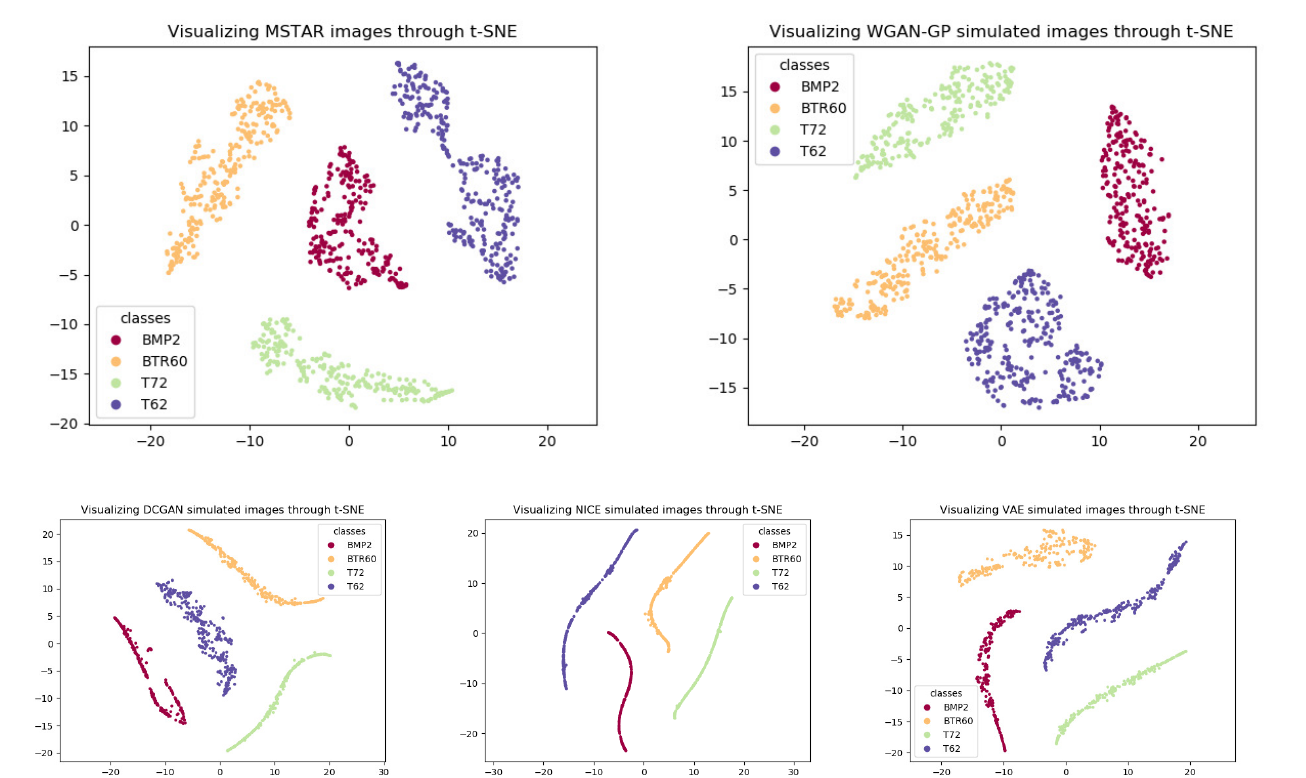
Figure 21. The two-dimensional t-SNE representation of features. From top to bottom, from left to right, the representation of real detaset, WGAN-GP , DCGAN, NICE, VAE